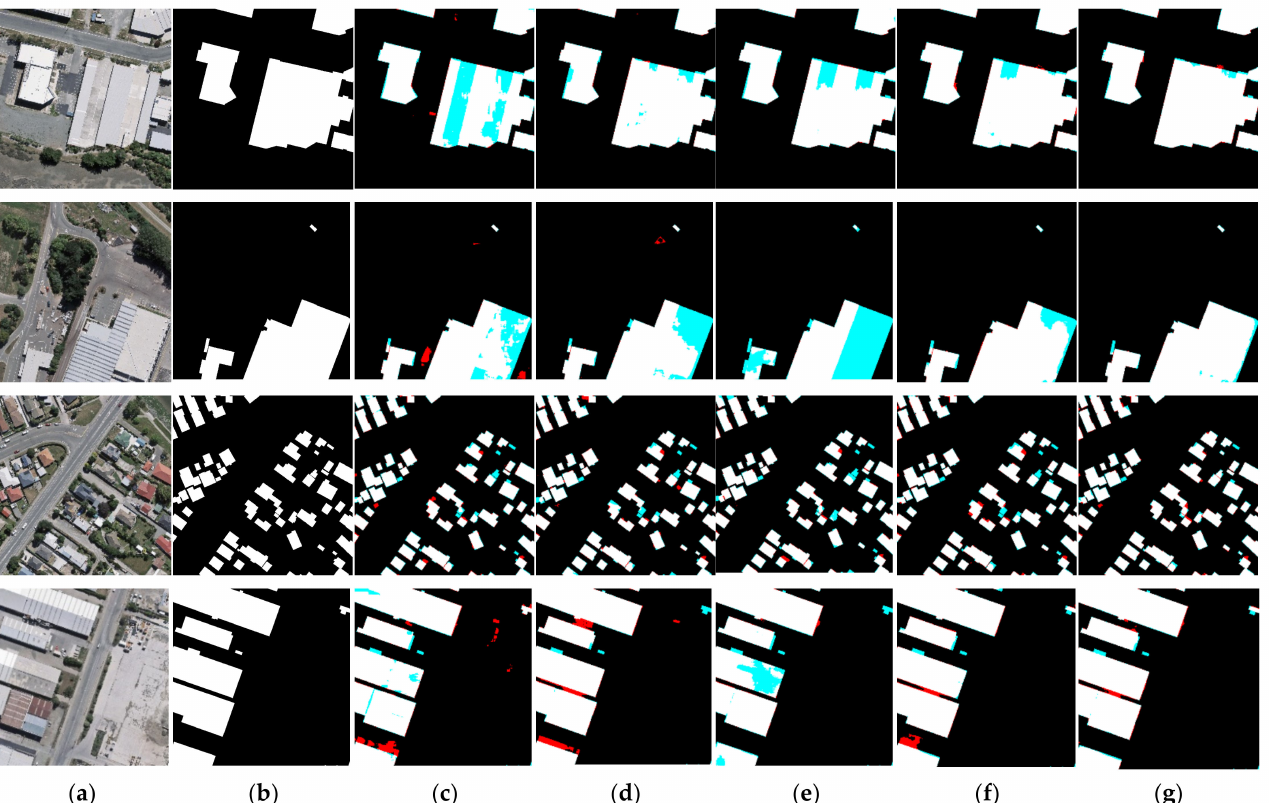
Figure 13. Building extraction results for the WHU dataset according to each deep learning model. The red and cyan regions indicate false positives and false negatives, respectively. ( a ) Original image. ( b ) Ground-truth labels. ( c ) Results of SegNet. ( d ) Results of U-Net. ( e ) Results of FC-DenseNet. ( f ) Results of HRNet-v2. ( g ) Results of